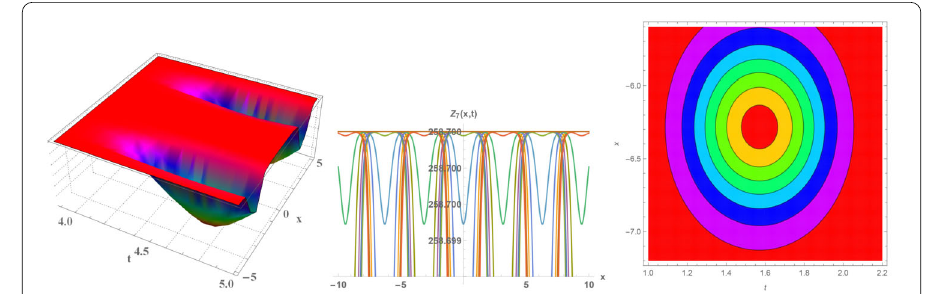
contour plot (c) to explain the overhead view of the solution when [ α = 1 , δ = 6, λ = 3, m = 1, n = 1, χ = 5, (cid:4) = 1] . 2